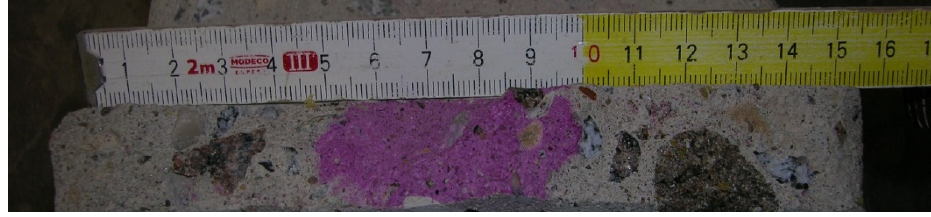
Table 1. Measurements of depth of carbonated zone.